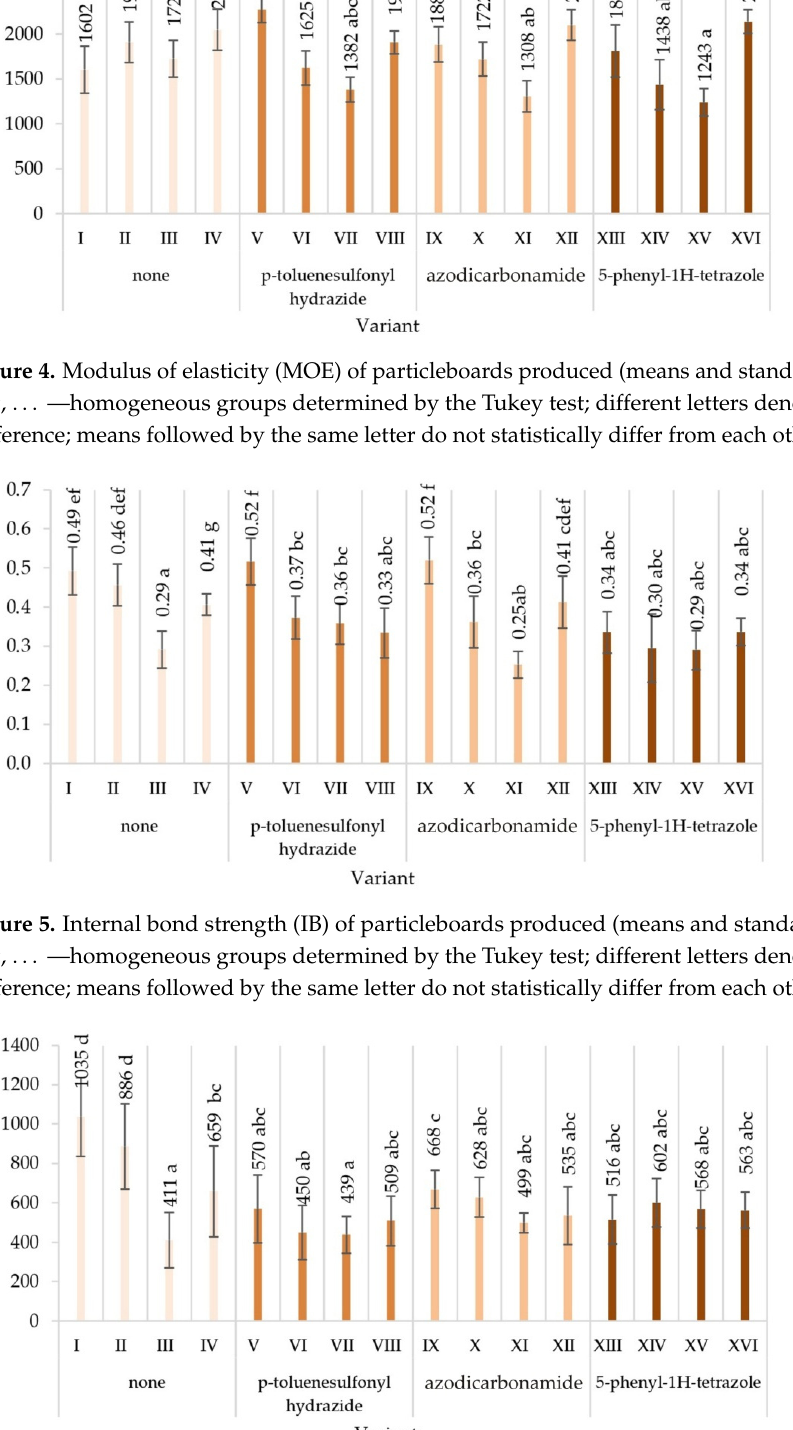
Figure 6. Screw holding parallel to the surface (SH II) of particleboards produced (means and standard deviation, a, b, c, …—homogeneous groups determined by the Tukey test; different letters denote a significant difference; means followed by the same letter do not statistically differ from each other).